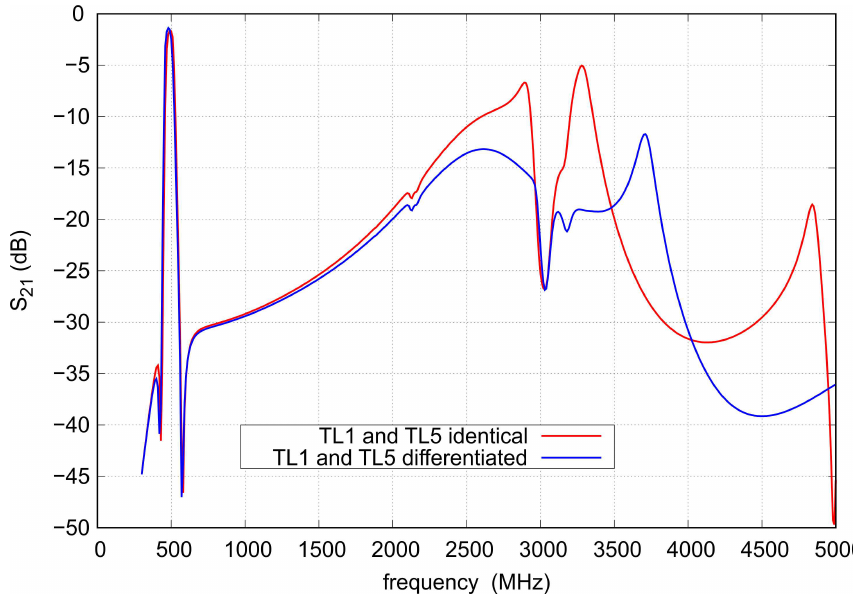
Figure 10. The S 21 for different impedances of transmission lines forming resonant circuits. To improve filter impedance matching in the upper part of the tuning range, the low- impedance sections of the TL8 line acting as 0.15 pF capacitors are added in series to the TL1 lines. The impact of these lines on the course of s 11 is illustrated in Figure 11.